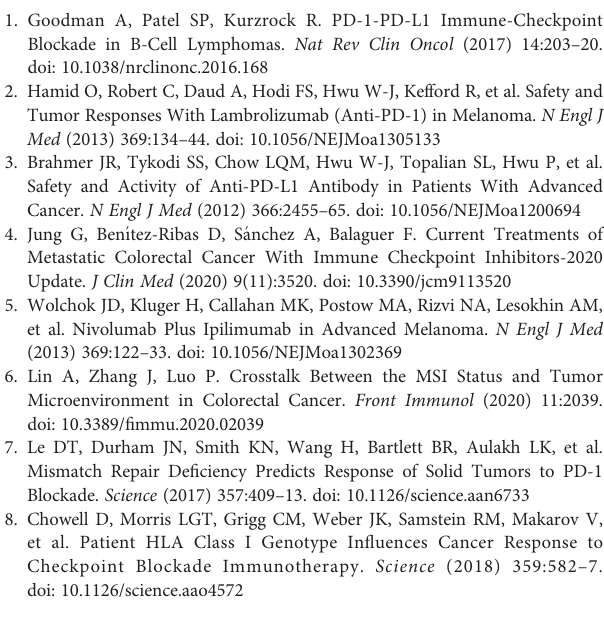
Supplementary Figure 2 | The heatmap showed the difference of IL-1 signaling related genes between the IL-1-MT and IL-1-WT group. Supplementary Figure 3 | The comparison of the difference of the expression some genes with pro-in fl ammatory activity (such as IL1RN, IL1R2, IL1B, IL1R1, IL1RAP, IL1A) between the IL-1-MT and IL-1-WT